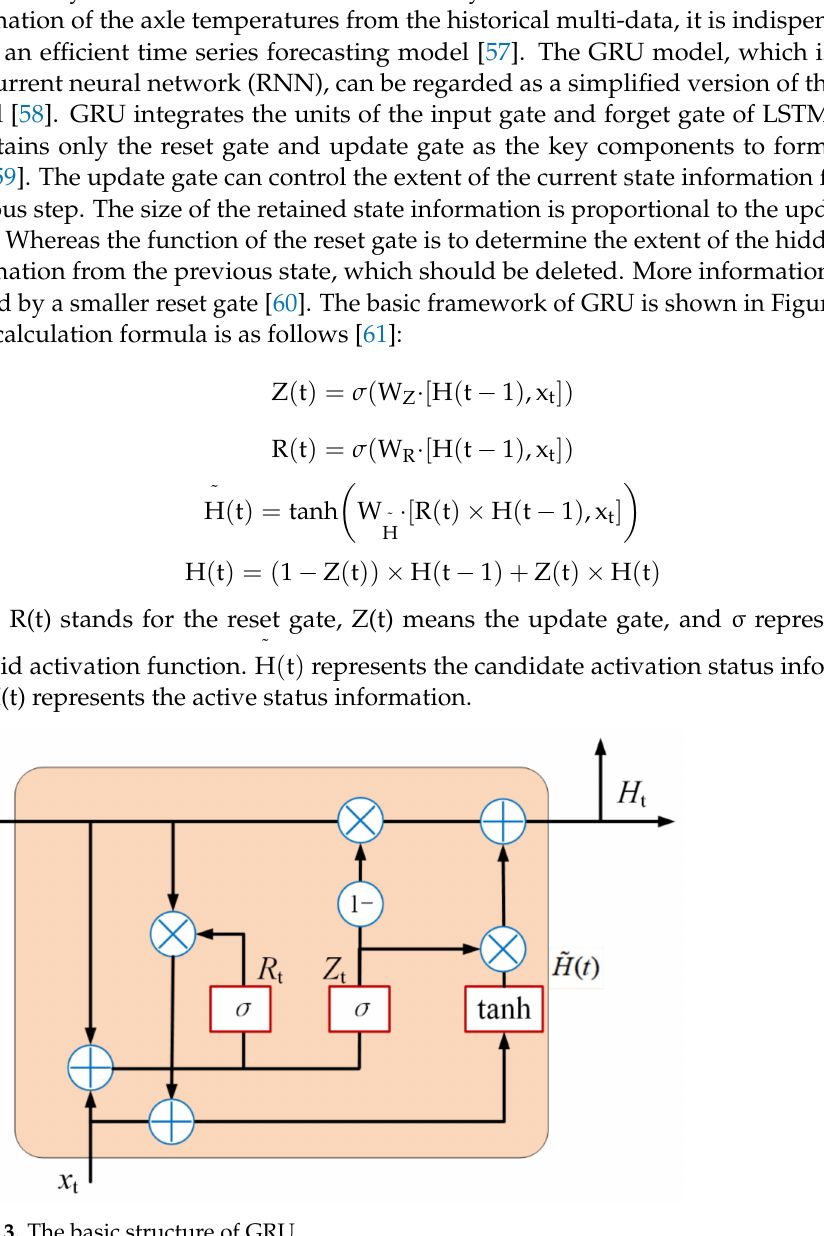
Figure 3. The basic structure of